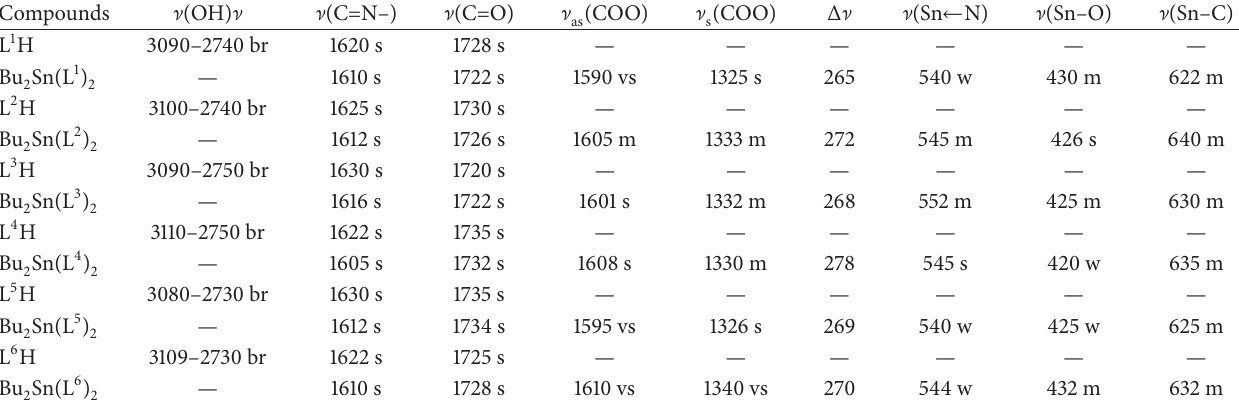
Table 2: Important IR spectral data (cm − 1 ) of Schiff bases and their corresponding organotin(IV) complexes.